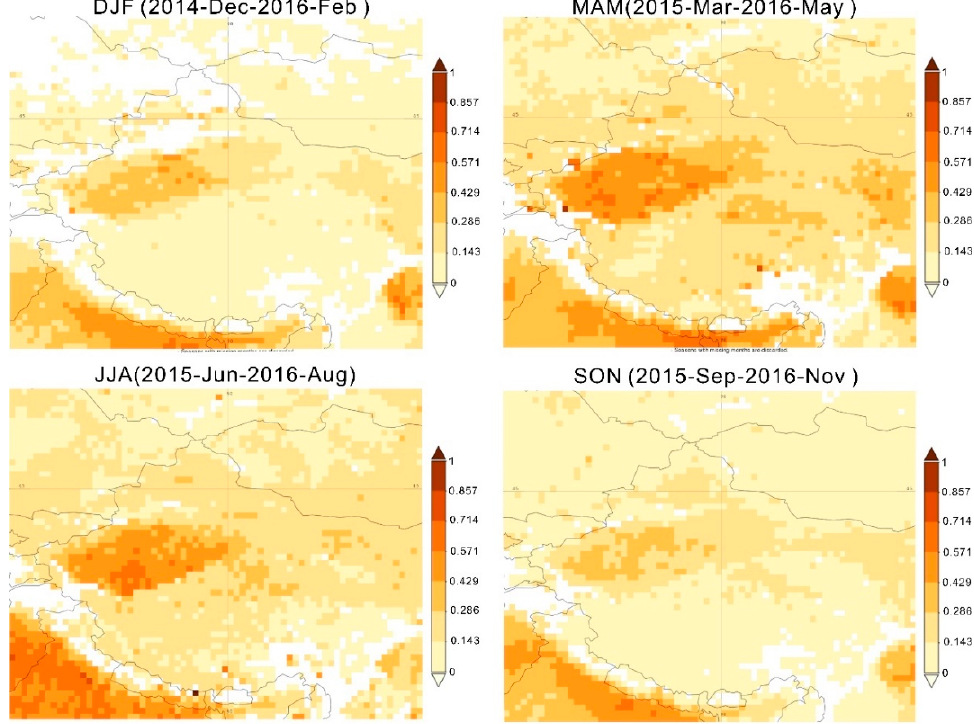
Figure 6. MODIS Aerosol Optical Depth at 0.55 microns for land Mean of daily Mean monthly (http://giovanni.sci.gsfc.nasa.gov) during each season in 2015–2017 in the Tibetan Plateau and surrounding areas.